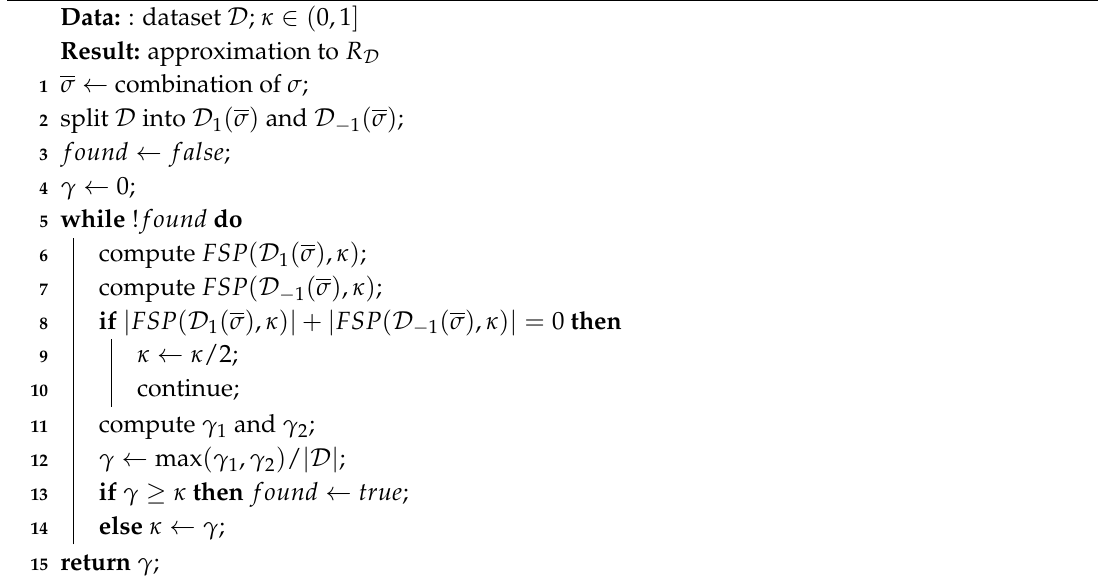
Algorithm 5: RadeApprox( D , κ ): algorithm for approximating the Rademacher complexity of sequential